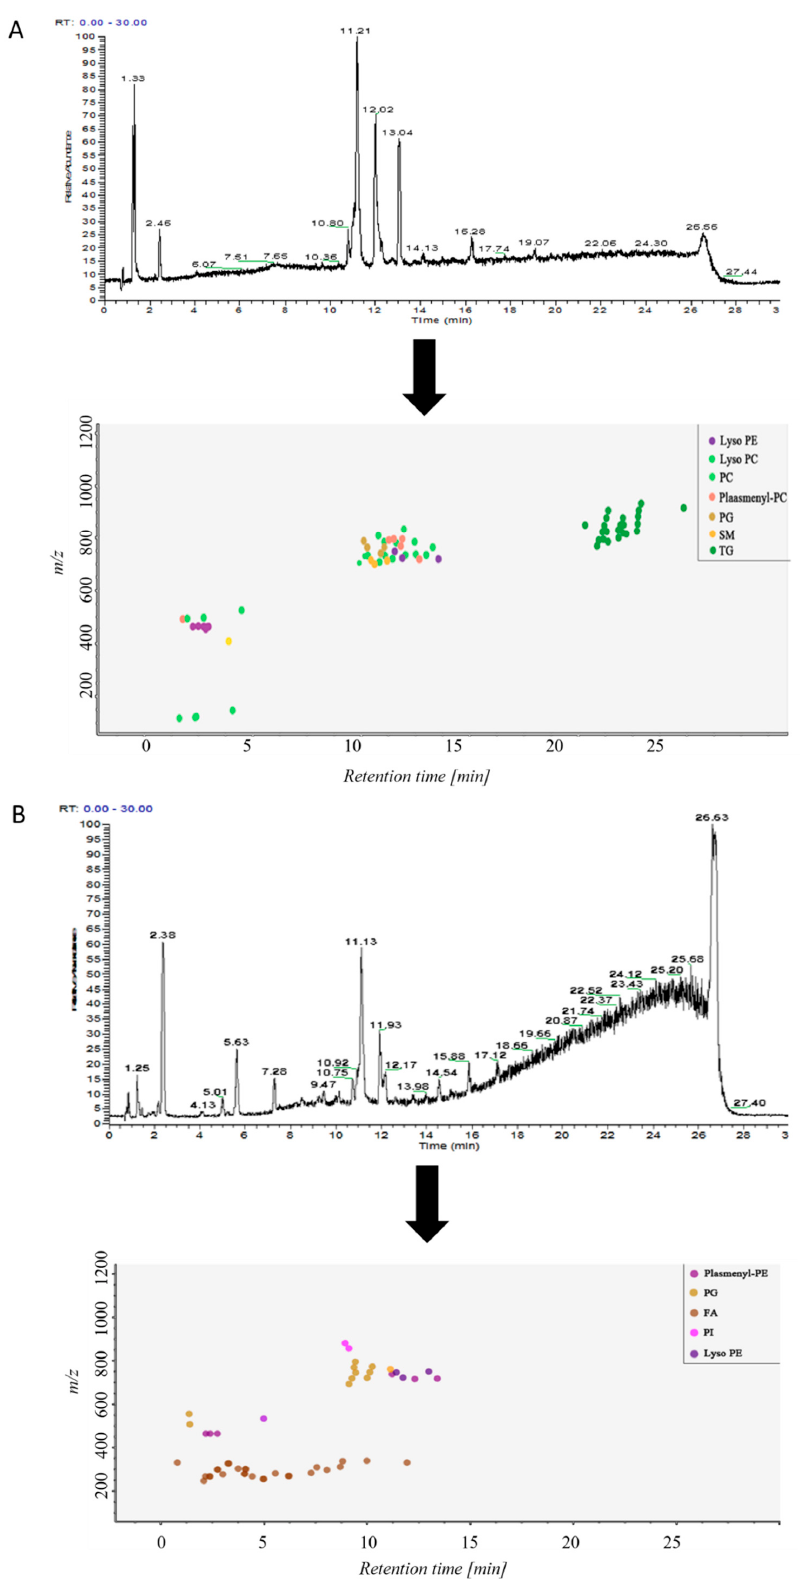
Figure 2. ( A ) TICs of lipids in BALF of mice and distribution of lipids in different retention times in positive ion mode in MS-DIAL software, ( B ) TICs of lipids in BALF of mice and distribution of lipids in different retention times in negative ion mode in MS-DIAL